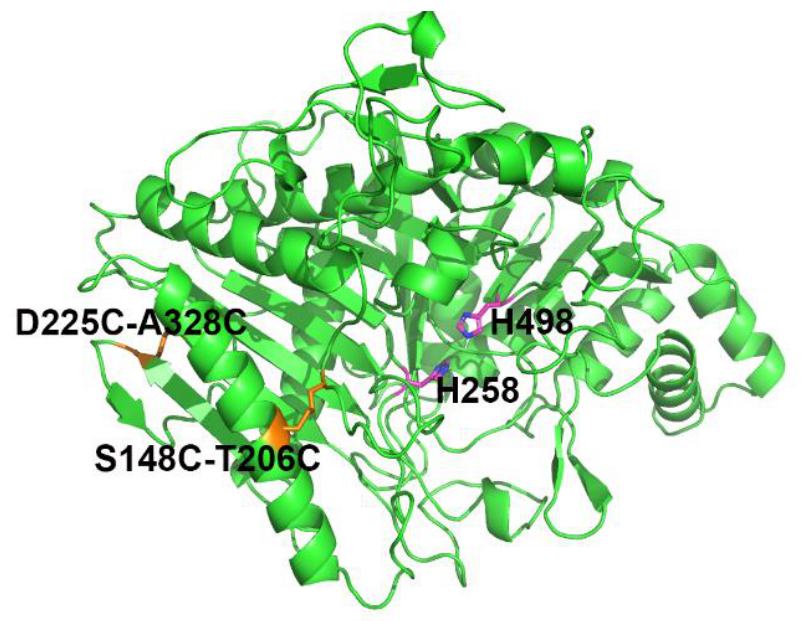
Figure 2. Three-dimensional model of the mutant S148C-T206C/D225C-A328C. The structural model of mutant S148C-T206C/D225C-A328C was built with Modeller, and the crystal structure of wild-type MsPLD (PDB ID 7WU1) was used as the template. Introduced disulfide bonds S148C-T206C and D225C-A328C were shown as orange sticks. The catalytic residues H258 and H498 were shown as magenta sticks.